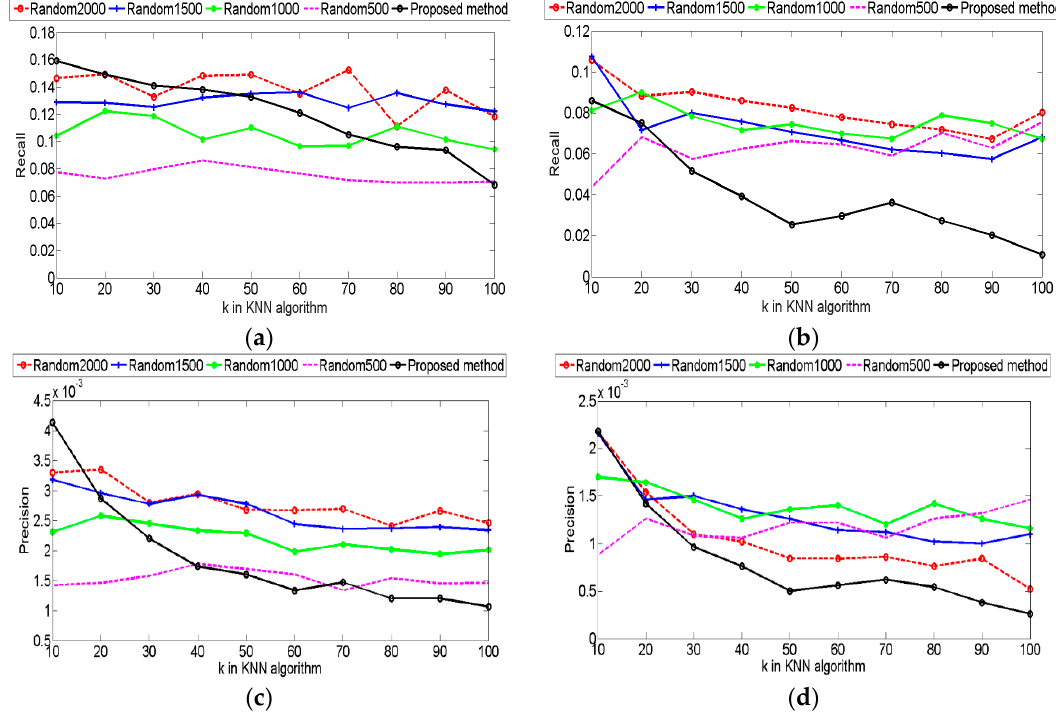
Figure 2. ( a ) Recall criterion with similarity measures of cosine; ( b ) Recall criterion with similarity measures of NHSM; ( c ) Precision criterion with similarity measures of cosine; ( d ) Precision criterion with similarity measures of NHSM.